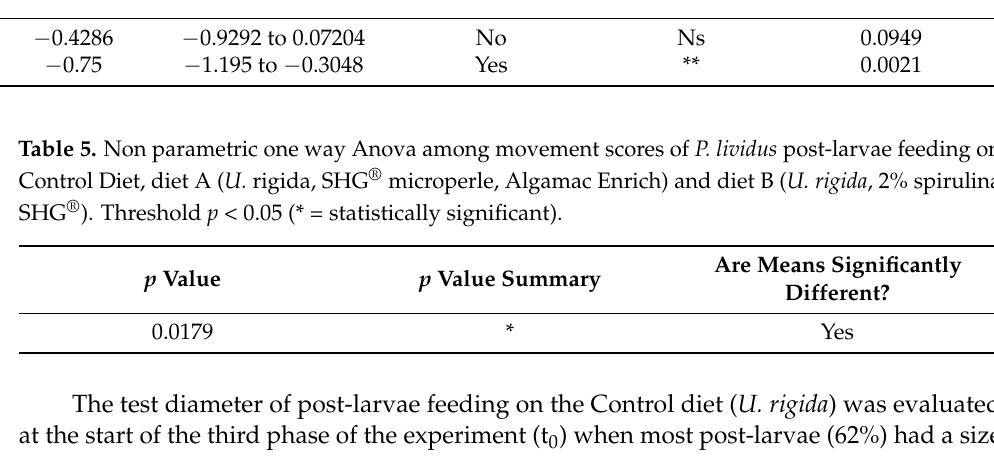
Table 4. Dunnett’s multiple comparisons test between movement scores of P.lividus post-larvae feeding on control diet ( U. rigida ), diet A ( U. rigida , SHG ® microperle, Algamac Enrich) and diet B ( U. rigida , 2% spirulina SHG ® ) AB. Threshold p < 0.05 (** = statistically significant; ns = not statistically significant). Mean Diff.